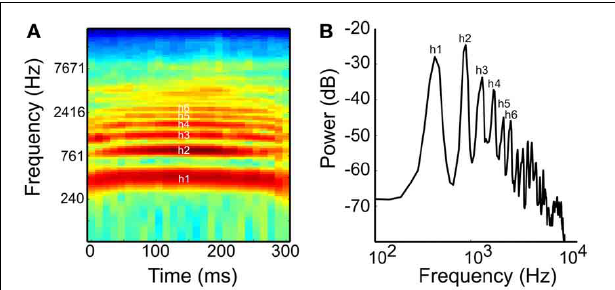
FIGURE 1 | (A) Spectrogram and (B) power spectrum of the coo call used as a naturalistic harmonic sound in this study. The coo consists of the first harmonic or fundamental (h1) and five prominent harmonics with amplitudes above − 50dB (2nd to 6th harmonics, h2–h6; FFT size: 1024, Hann window). The interval between h1 and h2 is one octave and that between h2 and h3 is a perfect